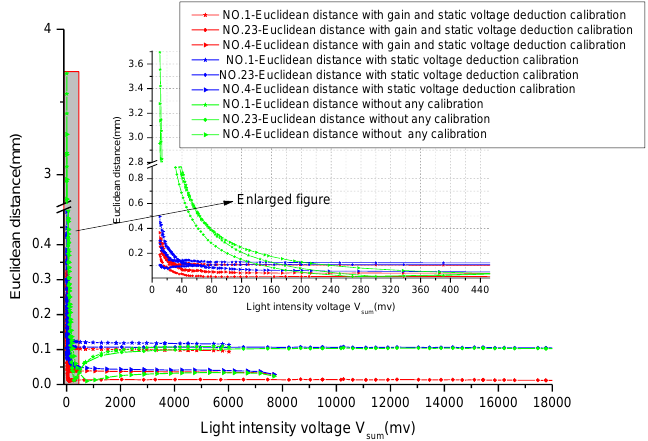
Figure 14. ( a ) The coordinates of sampling points without any calibration. ( b ) The blue coordinates with static voltage deduction calibration and the red coordinates with static voltage deduction and equalization gain calibration.